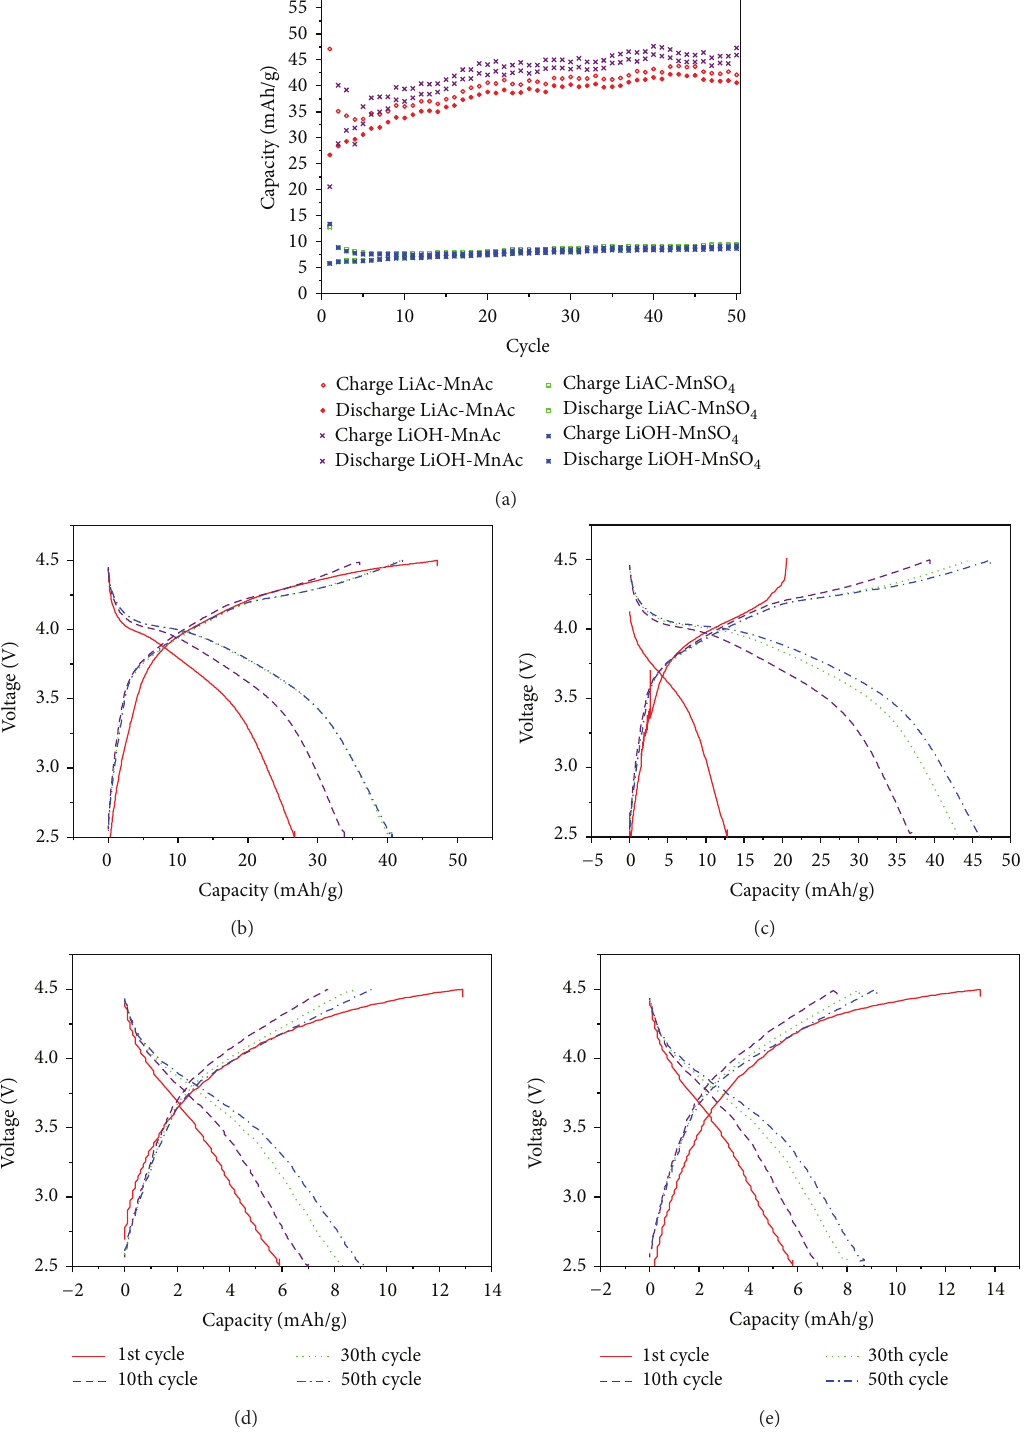
Figure 4: (a) Cycle property of LiMnPO 4 using various precursors and charge-discharge curve: (b) sample A, (c) sample B, (d) sample C, and (e) sample